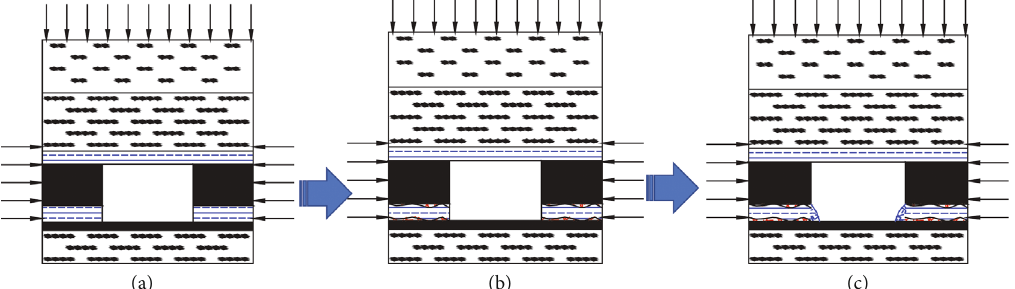
Figure 2: Sidewalls slip process of roadway in 11506 working face.